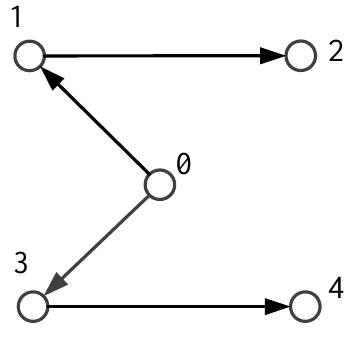
Figure 2. The communication graph.